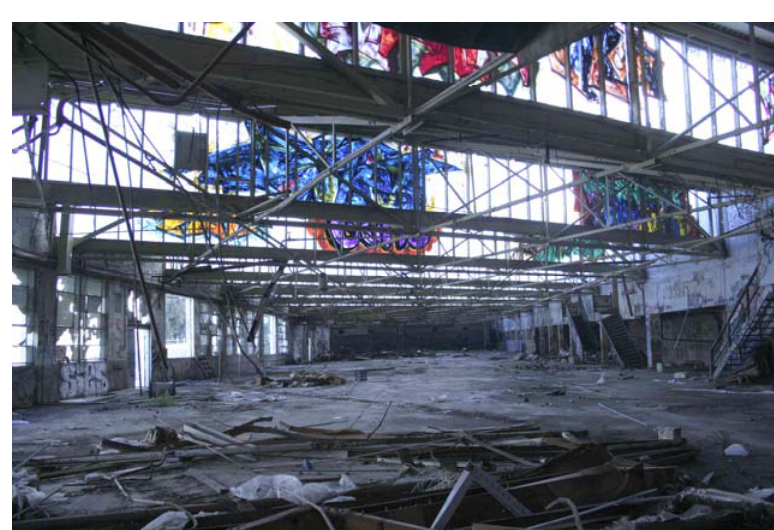
Figure 1. Abandoned factory